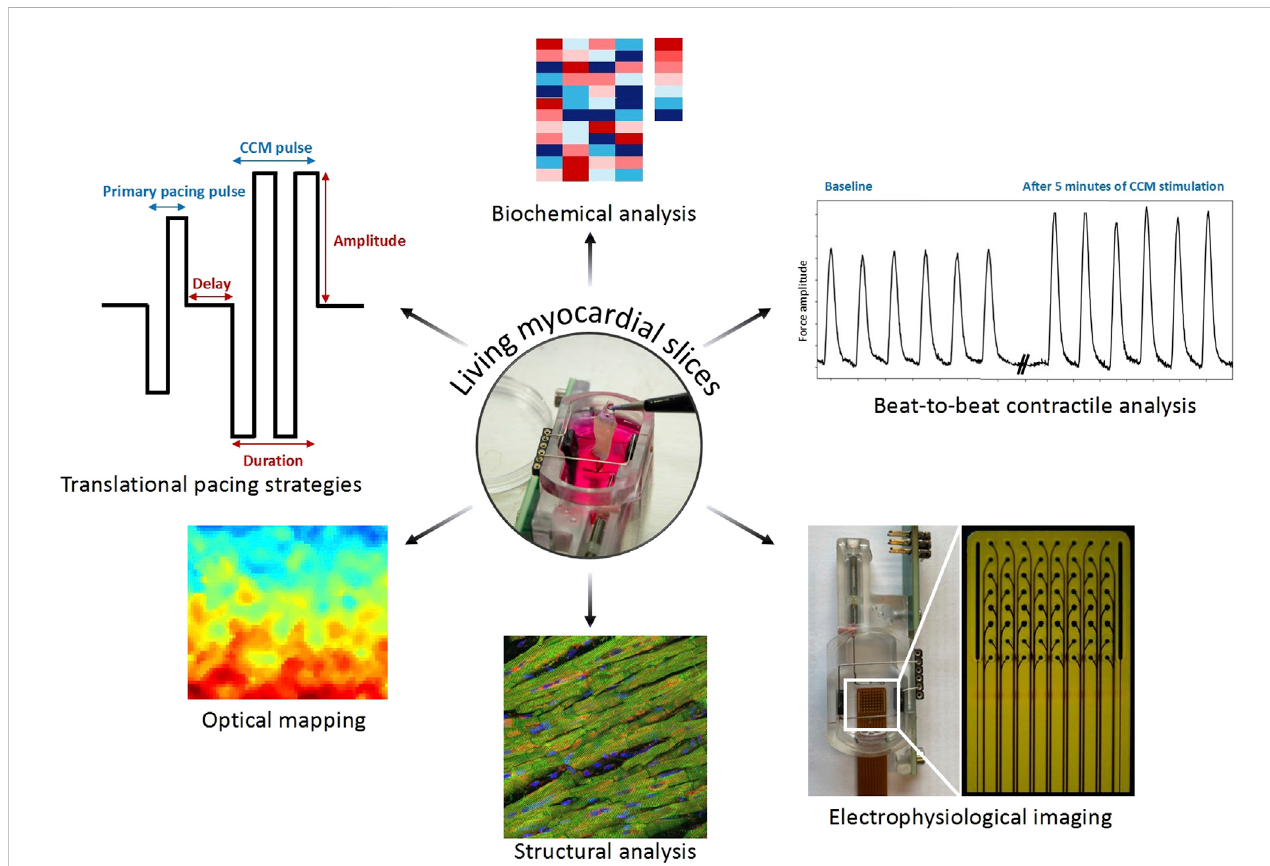
FIGURE 1 Living myocardial slices form a representative human in vitro translational cardiac device research